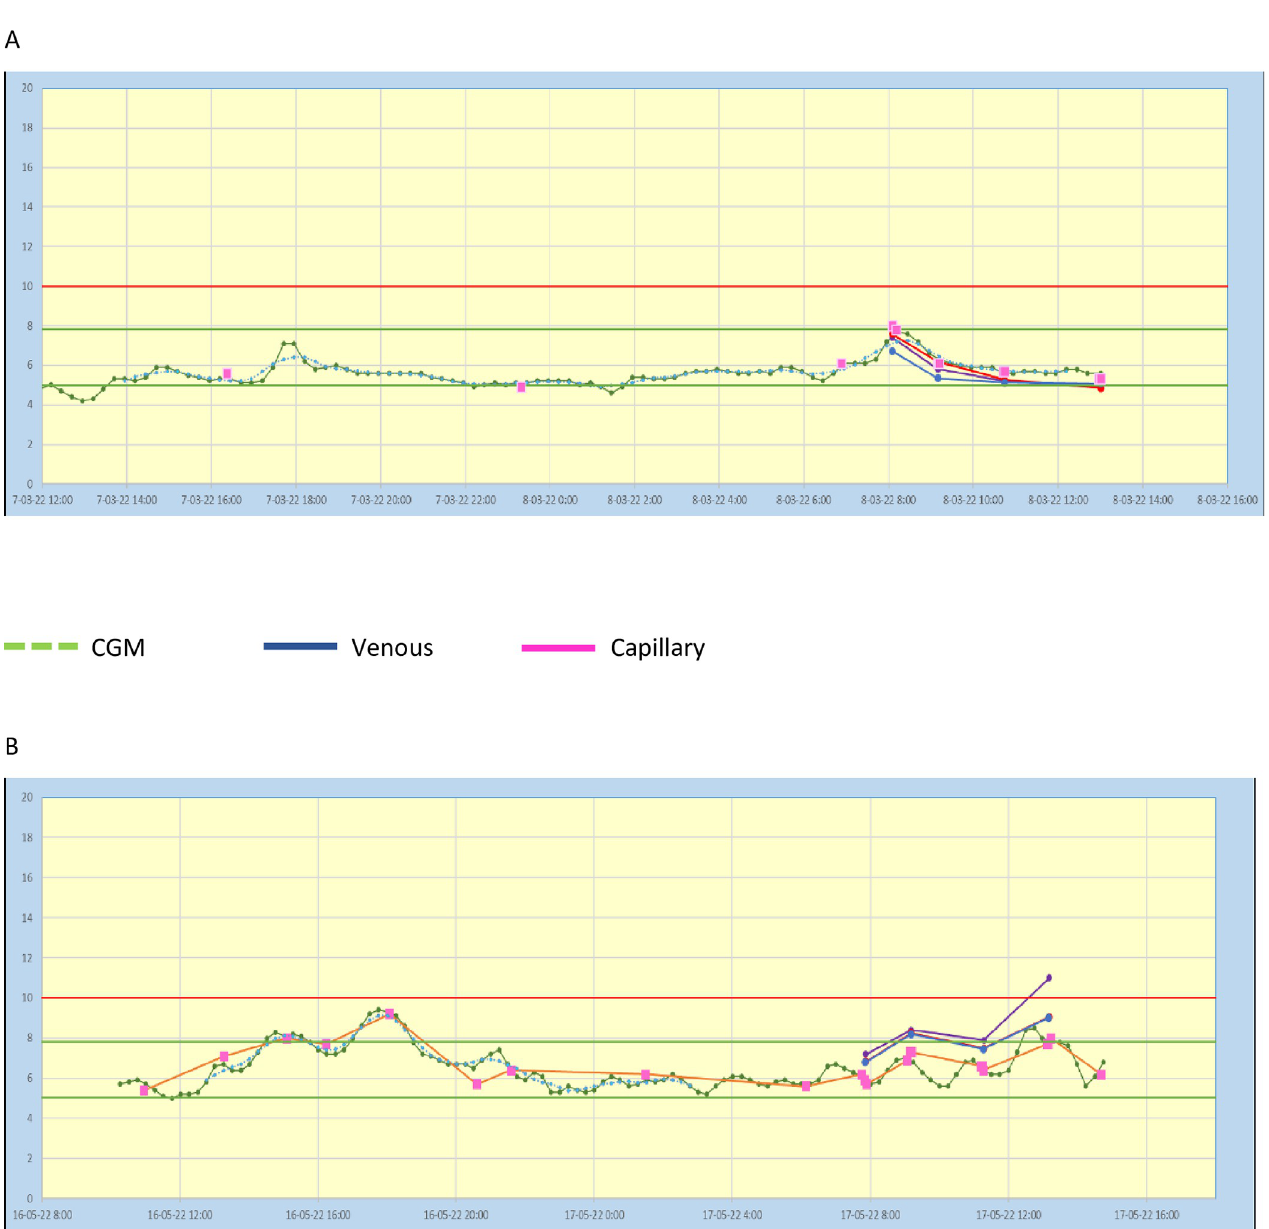
Fig 2. CGM data and capillary and venous glucose levels of a patient with glucose levels in normal range (A) and with hyperglycemia (B).